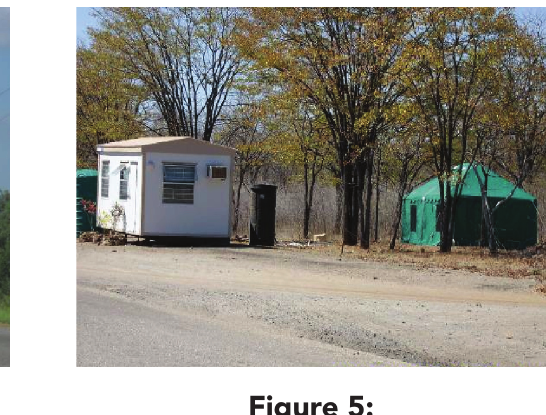
Rudimentary facilities